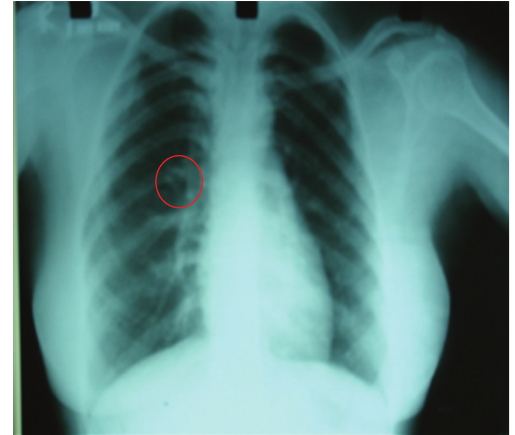
Figure 3: Chest radiograph showing a bifid right fifth rib.